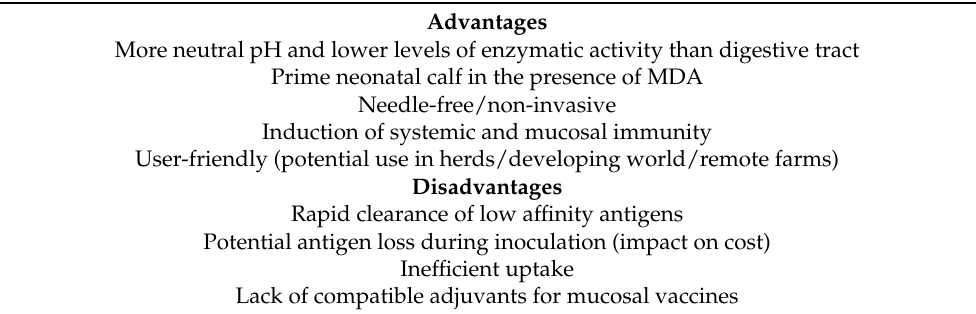
Table 2. Main advantages and disadvantages of intranasal vaccination in cattle.